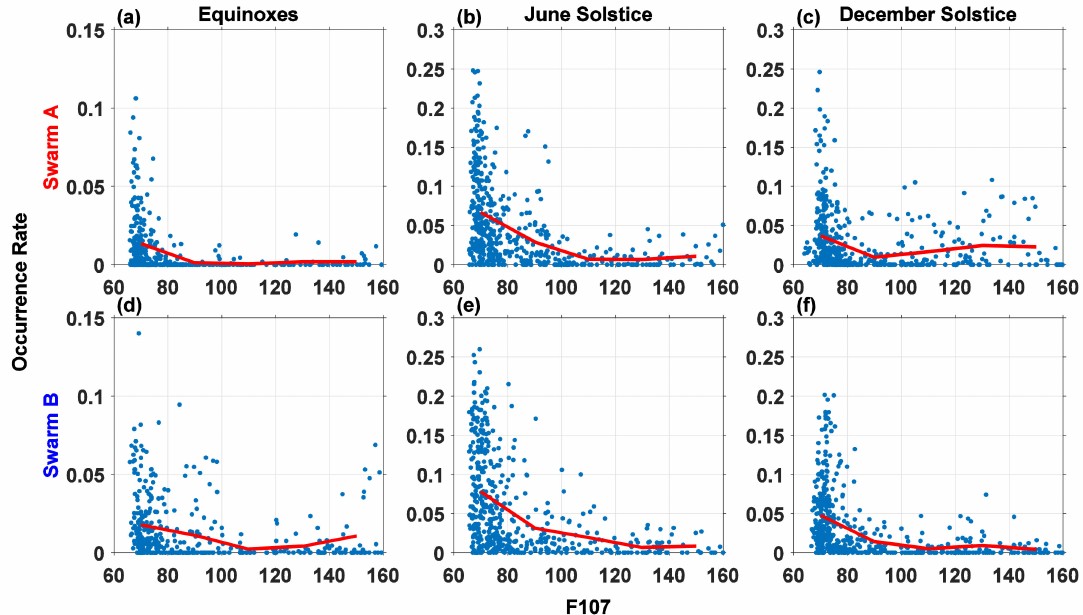
Figure 11. Variations of the plasma irregularity occurrence rate as a function of F107 after midnight by RODI for different satellites at middle latitudes ( ± 30 ◦ – ± 40 ◦ geomagnetic latitudes). The panels from left to right show results during the equinoxes ( a , d ), June solstice ( b , e ), and December solstice ( c , f ), from top to bottom show results for Swarm A and Swarm B. The red lines are connected by the mean values of the F107 index every 20